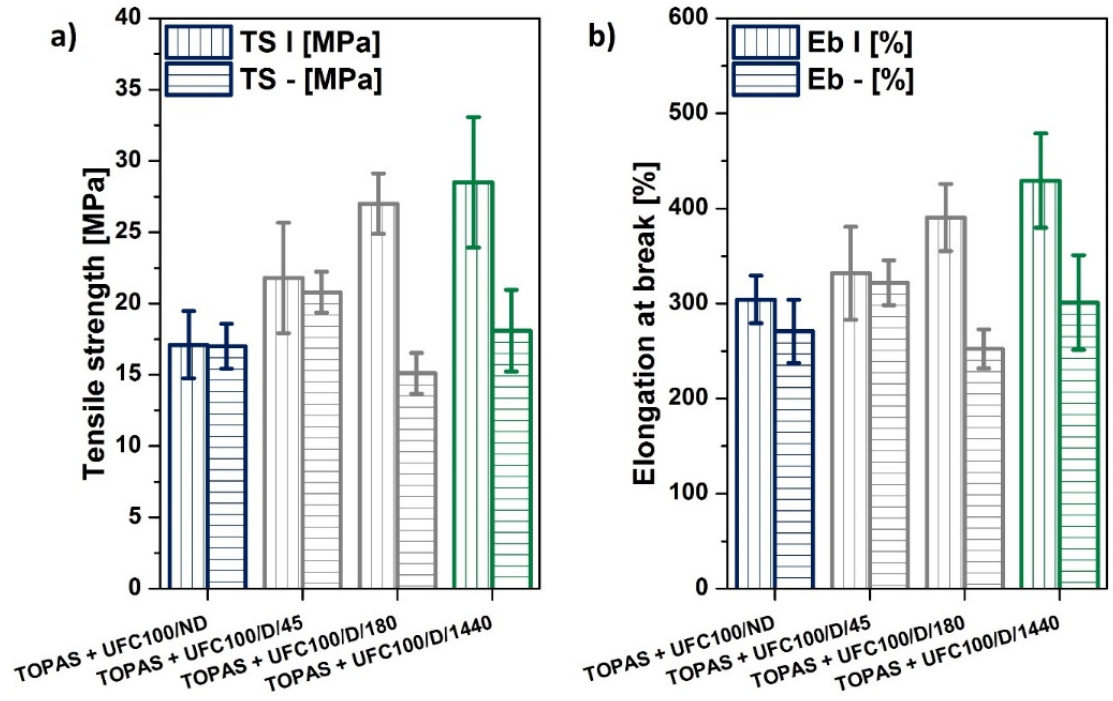
Figure 7. Mechanical properties of the investigated composite samples. ( a ) Tensile strength and ( b ) elongation at break. Table 5. Tabularized values of the orientation influence factor for the investigated composites